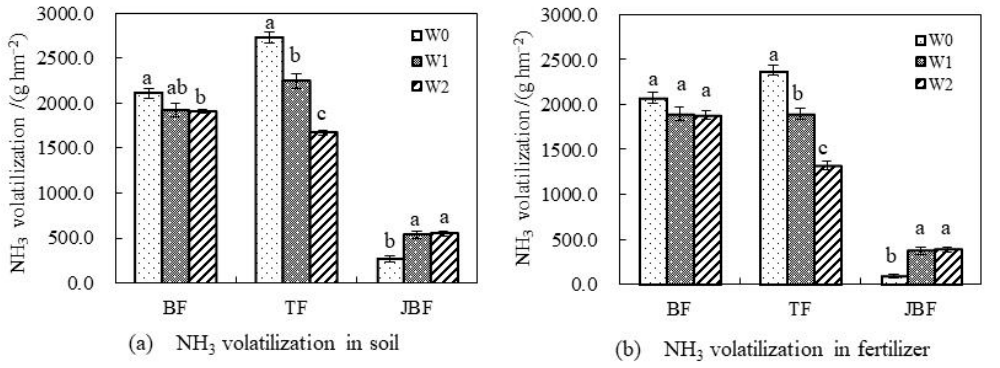
Figure 3. Changes of NH 3 volatilization loss in paddy fields under different irrigation modes, Figure a described NH 3 volatilization loss in soil, and Figure b described NH 3 volatilization loss in fertilizer. (BF, TF, JBF represented the base fertilizer, tilling fertilizer, and jointing-booting fertilizer, a, b and c in the figure represented differences between groups for significance